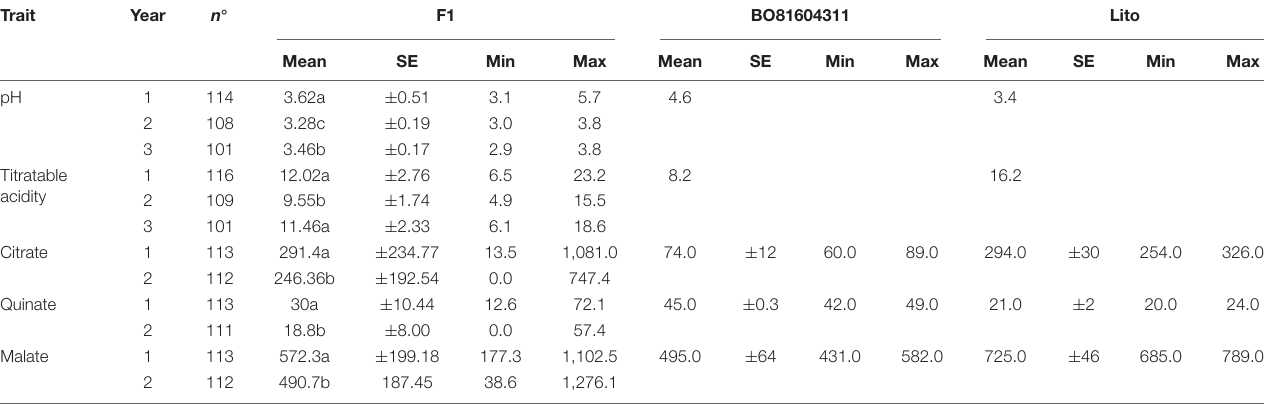
TABLE 1 | Mean, minimum, maximum, and SE of the traits observed in the F1 population and parents subdivided by year of observation.